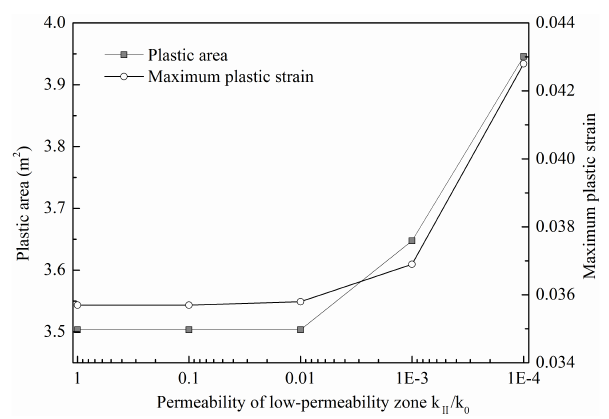
Figure 8. Gas distribution after 10 5 years of gas migration. 3